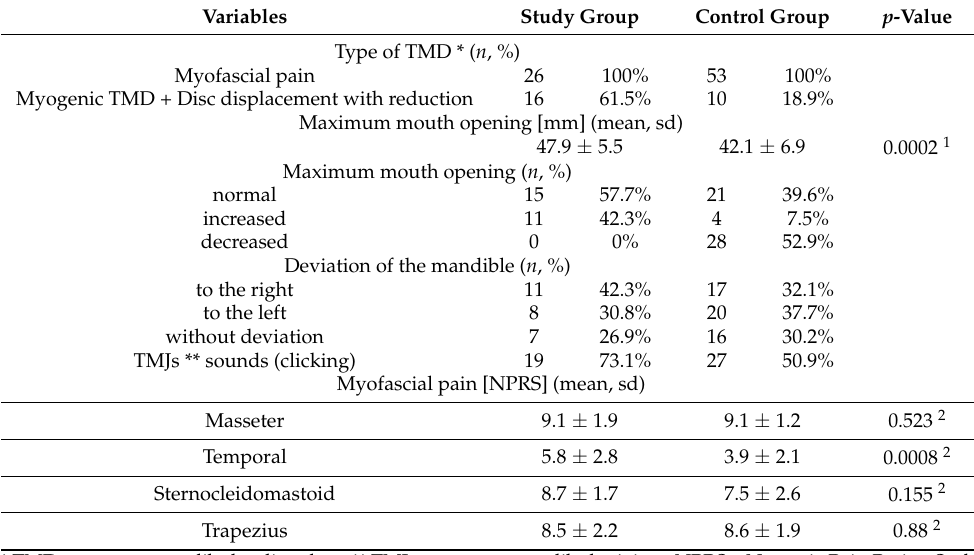
Table 2. Baseline characteristics of TMD symptoms among